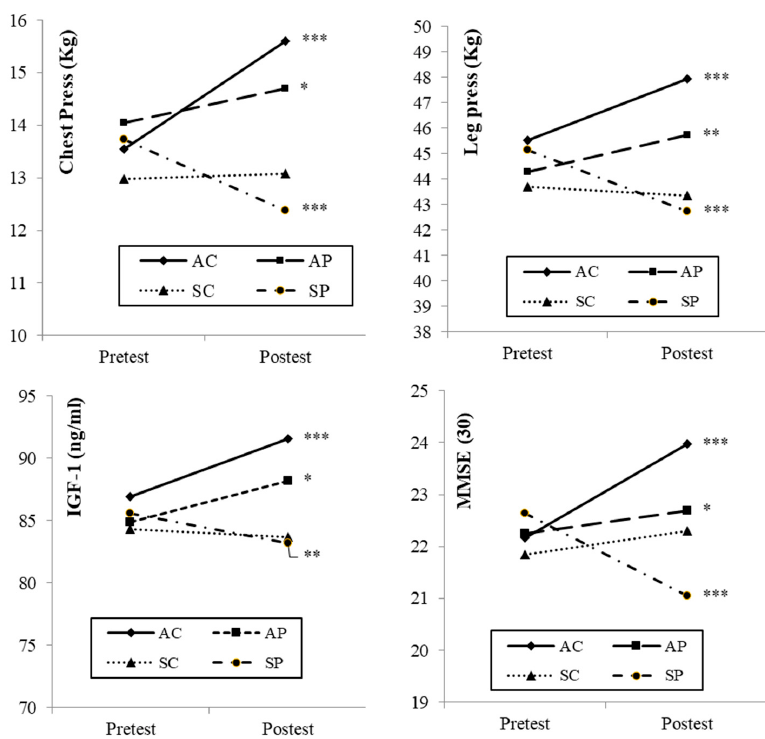
Figure 4. Intragroup post-test–pre-test comparisons. Wilcoxon’s or Student’s t -test according to normality. Significant differences (* p < 0.05; ** p < 0.01; *** p < 0.001). AC: Active Clean; AP: Active normality. Significant di ff erences (* p < 0.05; ** p < 0.01; *** p < 0.001). AC: Active Clean; AP: Active Pollution; SC: Sedentary Clean; SP: Sedentary Pollution.